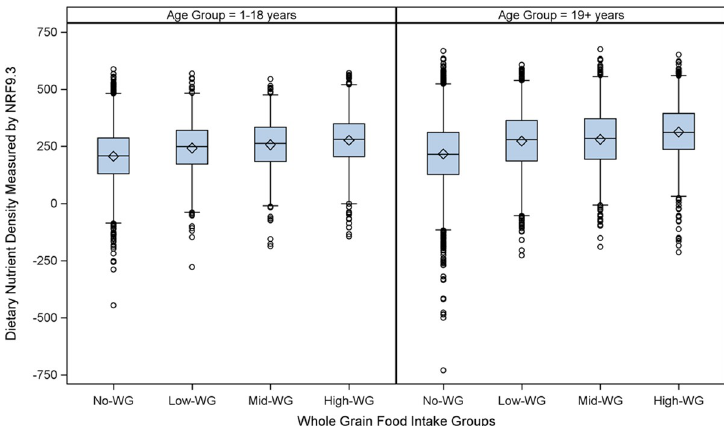
Fig 1. Diet quality, measured by the nutrient rich food index 9.3, among Canadian children and adults stratified by whole grain food intake. Data are from the Canadian Community Health Survey (CCHS) 2015. The left panel shows results for children 1 to 18 years and the right panel shows results for adults 19 years and older. Data are presented as boxplots for the Nutrient Rich Food Index (NRF) 9.3 (displayed on the y-axis in arbitrary units), a measure of nutrient density adapted to the total diet that calculates the sum of the contribution to daily recommendations for nutrients to encourage (fiber, protein, vitamin D, vitamin C, iron, calcium, potassium, vitamin A, and magnesium) minus the sum of the contribution to daily recommendations for nutrients to limit (total sugar, sodium, and saturated fat) per 2000 kcals. Participants were stratified according to whole grain (WG) food consumption reported on a single 24 hr dietary recall. The no-WG group reported consuming no whole grain foods (children n = 3,305; adults n = 7,578); The remaining participants that consumed whole grains were divided according to age-specific tertiles into low-whole grain (low-WG; children n = 3,305; adults n = 7,578), mid-whole grain (mid- WG, children n = 1,077; adults n = 2,044) and high-whole grain (high-WG; children n = 1,101; adults 2,141) food intake. The boxplot displays the median (center line of the box), the mean (diamond), the 25 th percentile (lower line of the box), the 75 th percentile (upper line of the box), the 5 st percentile (lower end of the whisker), the 95 th percentile (upper end of the whisker), and outliers (open circles). Statistical significance was tested using linear regression adjusting for gender, age, BMI, low-income status, supplement use, and total dietary energy intake and we found a statistically significant (p < 0.0001 for both children and adults) relationship between WG consumption status and diet quality, as measured by the NRF 9.3, as well as a statistically significant trend across groups of WG intake (p < 0.0001).